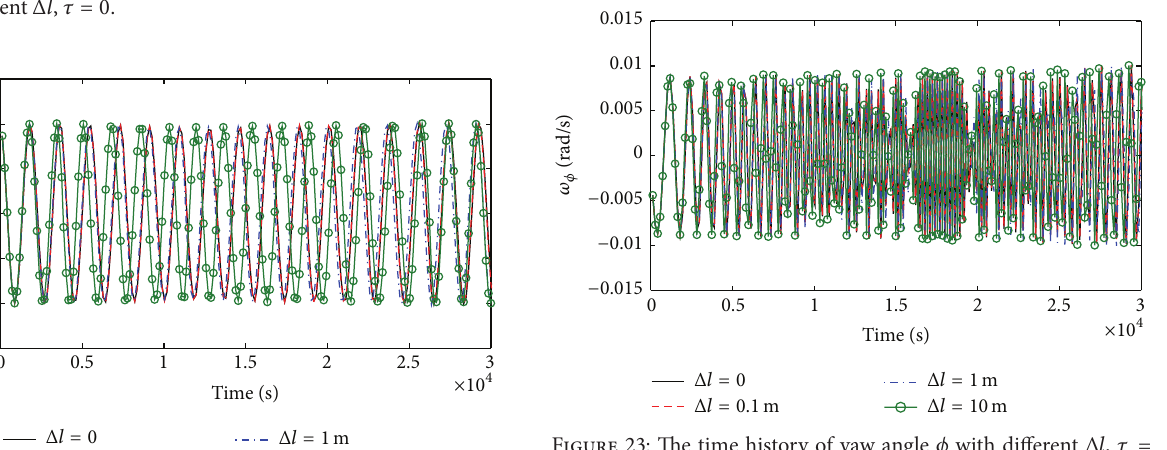
of those effects are that the angle 𝜙 and angular velocity oscillate irregularly over time.